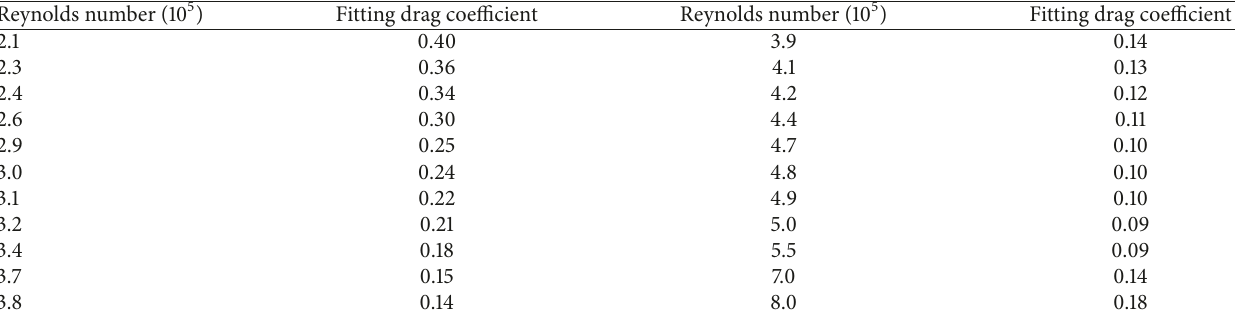
Table 2: Fitting drag coefficient from (9).